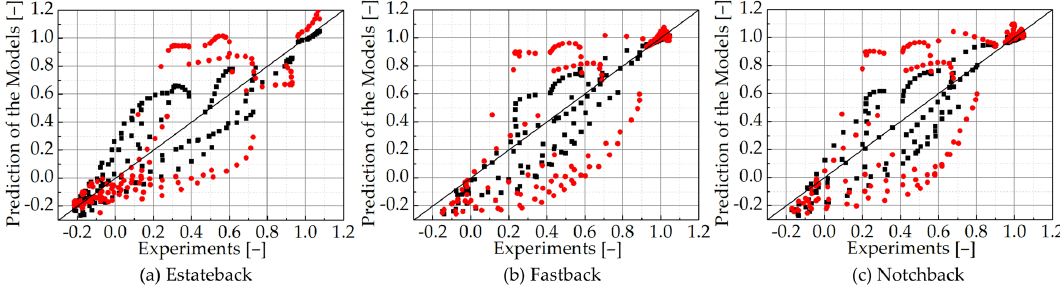
Figure 12. Figures illustrating the variations in the models of the experimental data. Plots located close to the diagonal lines indicate better reproducibility of the experiments. The red and black colored plots denote the results of the proposed model and the CFD, respectively.